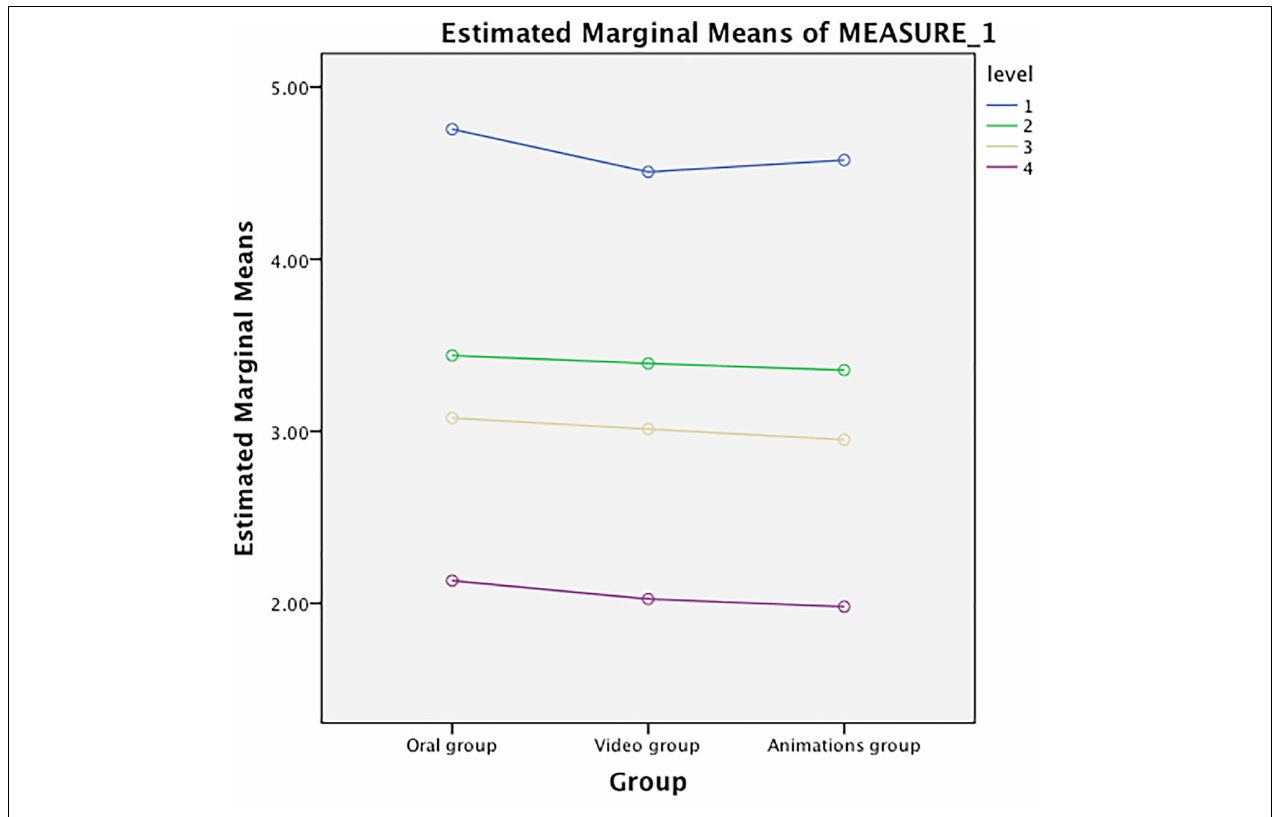
FIGURE 2 | Intergroup differences in the pain levels between the three